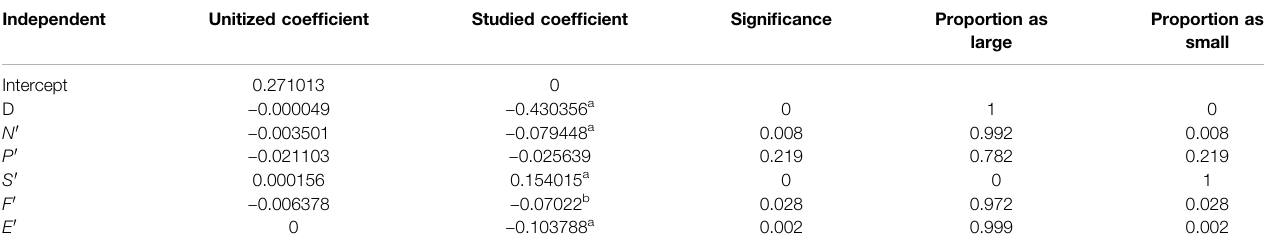
TABLE 7 | QAP regression analysis of each variable matrix.